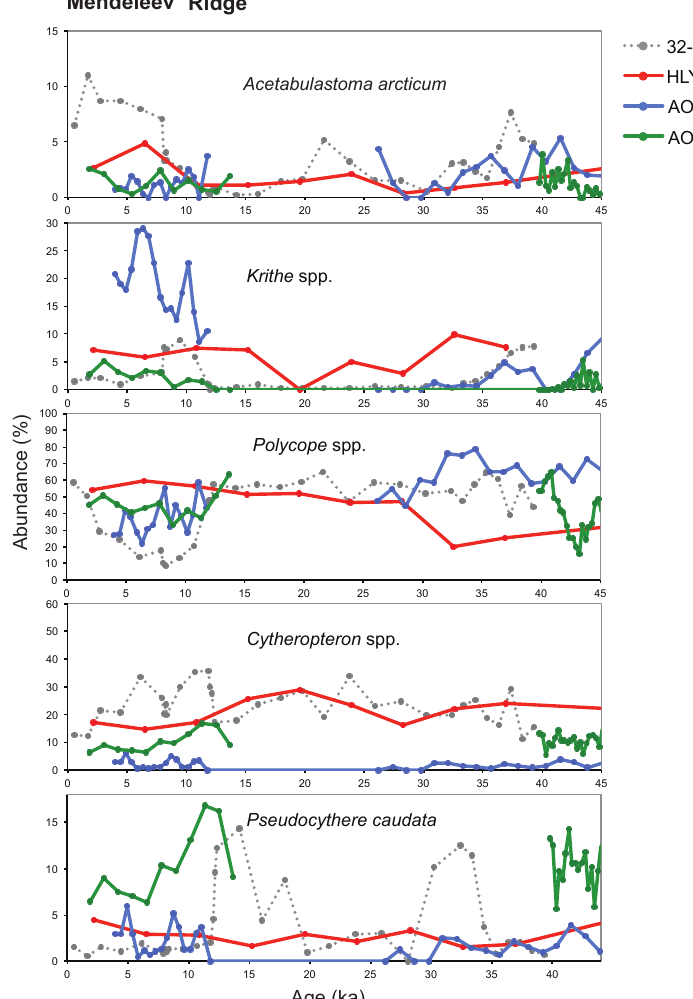
Figure 5. Relative frequencies (percent abundance) of dominant taxa in SWERUS 32-MC (dotted line) compared to other Mendeleev Ridge cores AOS94 8 (Poirier et al., 2012), AOS94 12, and HLY6. The chronology for core HLY6 (HLY0503-06JPC, 800m) is described in Cronin et al. (2013); core AOS94 8 (PI-94-AR-BC8, 1031m) in Cronin et al. (2010) and Poirier et al. (2012); and core AOS94 12A (PI-94-AR- BC12A, 1683m) in Cronin et al. (2010).